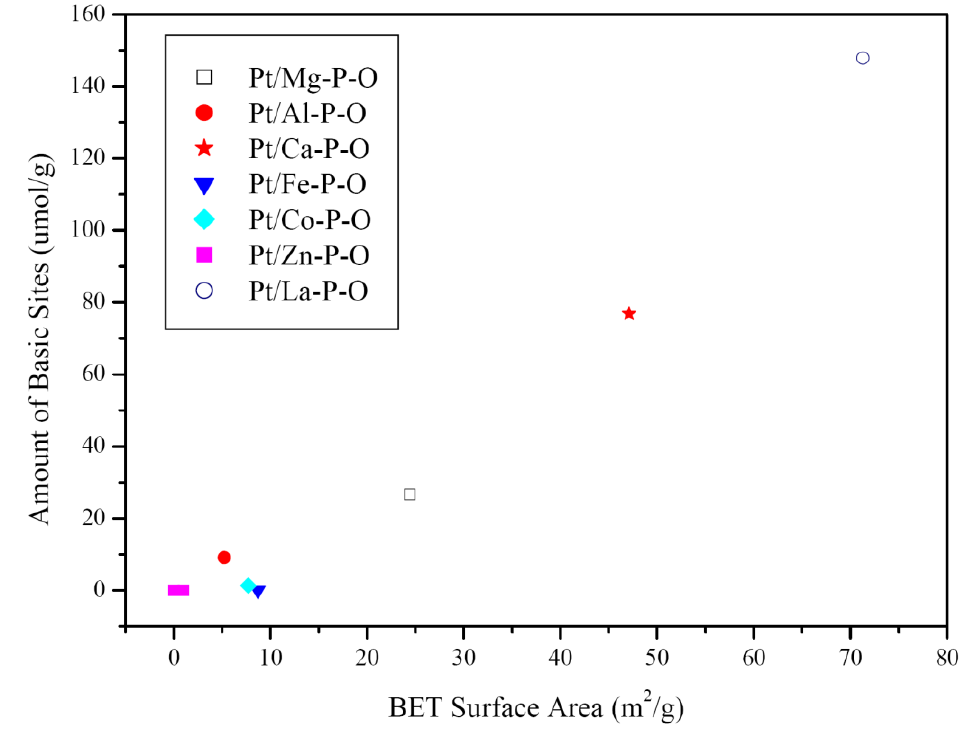
Figure 7. Correlation between the BET surface area and amount of basic sites of Pt/M-P-O catalysts calcined at 500